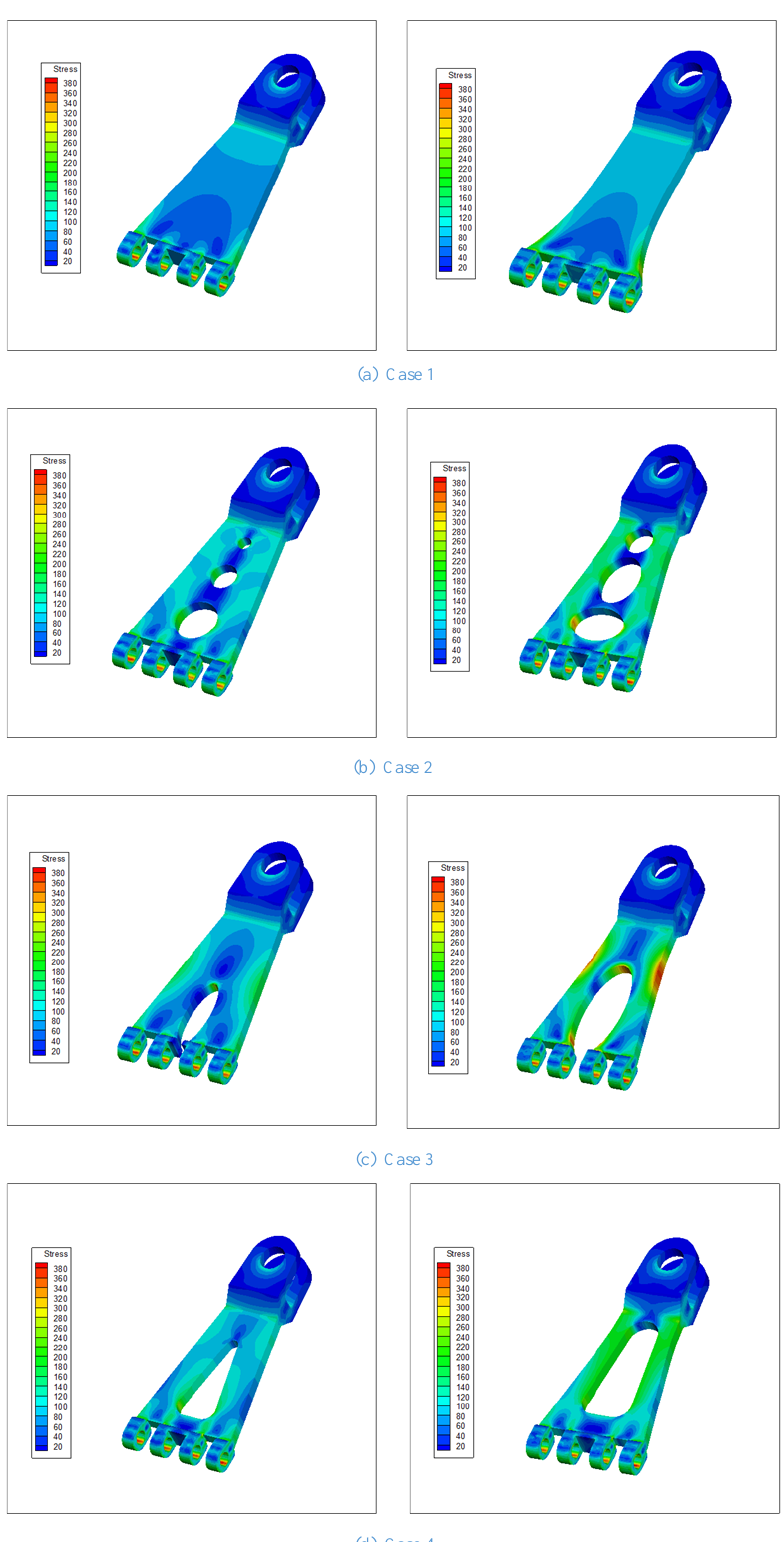
Figure 12. Initial and final von-Mises stress distributions of the four cases (left: initial, right: final). The corresponding iteration histories of the von-Mises stress and the mass of the four cases are shown in Figure 13.